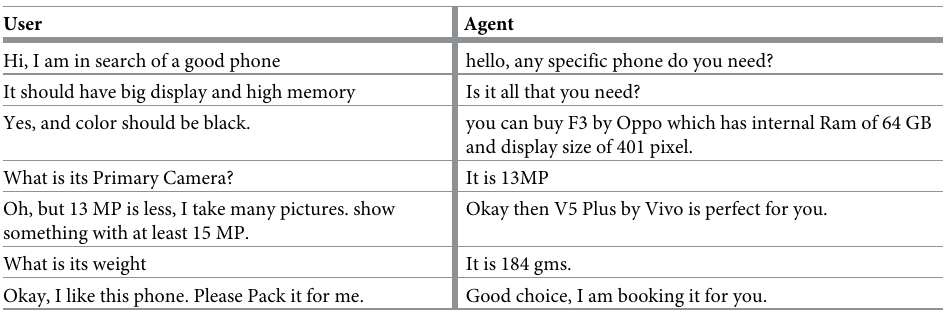
Table 2. Sample dialogue conversation 1.